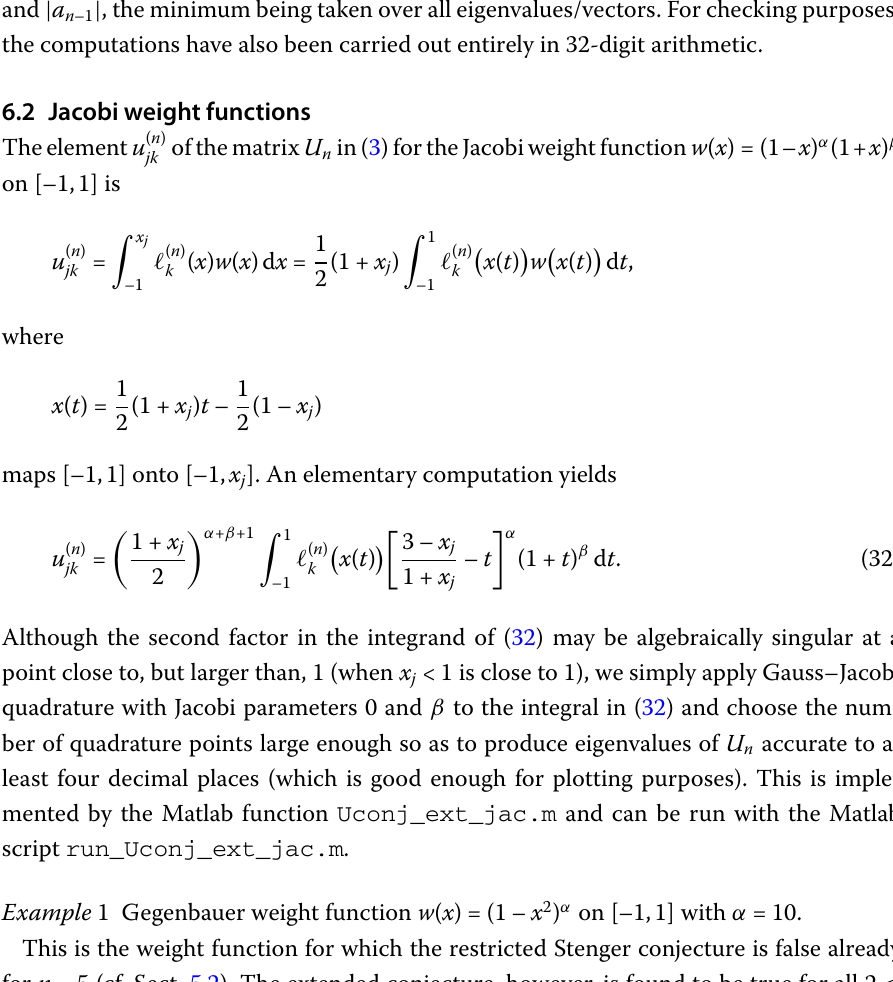
Table 5 The minimum values min int of | n min